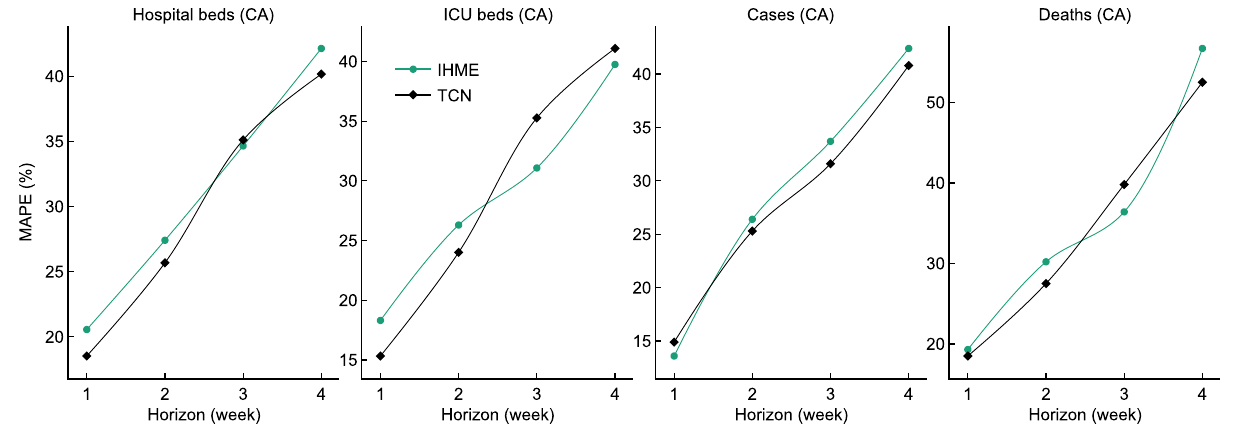
Figure 8. Models’ performance on IHME data, in terms of MAPE (%) of the forecasts in Canada .